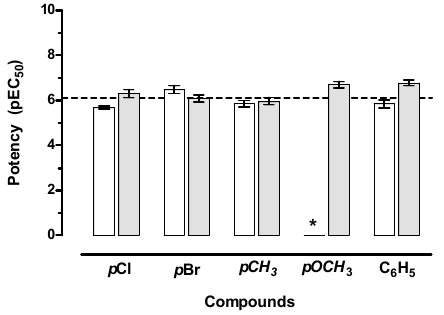
Figure 5. Potency (pEC 50 ) of 6 (R’ = H; white) and 7 (R’ = Ph; grey) derivative compounds on guinea pig left atria driven at 1 Hz. The dotted lines show the reference value of negative inotropic potency for diltiazem (pEC 50 ). * The p -MeO of 6 has not been synthesized. In no case were our selected myocardial L -Type calcium channel modulators 6 and 7 able to significantly inhibit the proliferation of tumor cells, and they did nothing to hamper the ABCB1 activity at low equitoxic concentration.